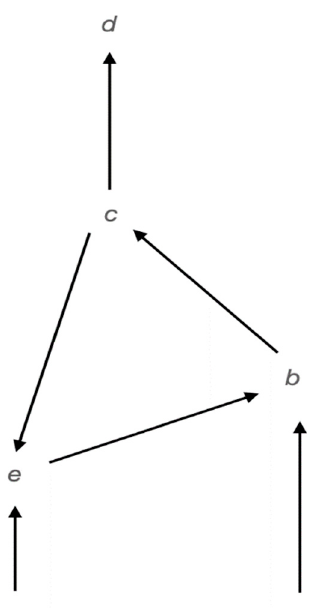
Figure 1. If I had not pressed that button?